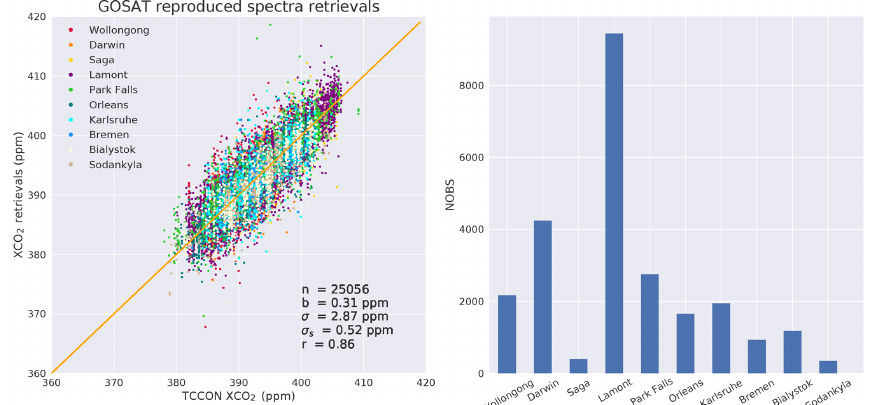
Figure 9. XCO 2 retrievals from MSR-d spectra reproduced from GOSAT measurements. As in Fig. 4, we included the statistical diagnostics of the study.